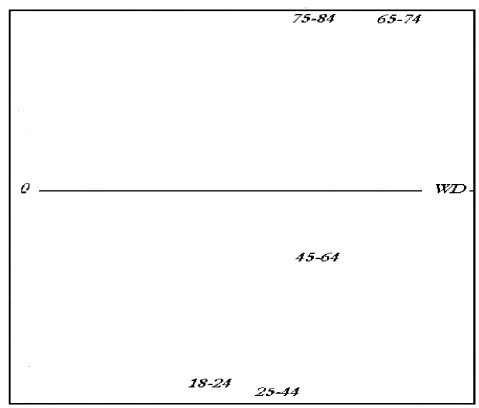
Figure 3 – Plot of the five time-use tables on first factorial plane (65,65% of total variance). Notes: WD is the mean (compromise) matrix and WD = 0 because data are standardised (mean = 0 and standard deviation =